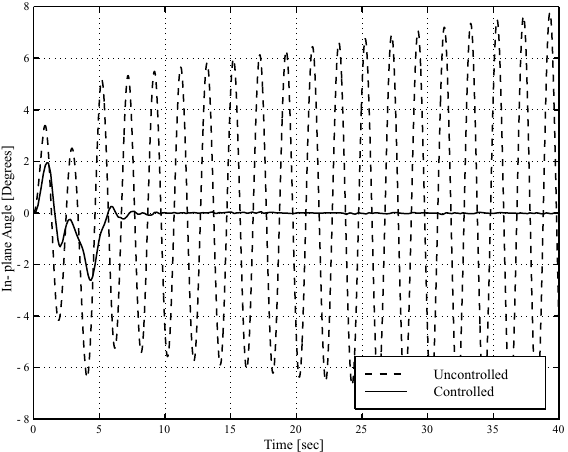
Fig. 21. Uncontrolled vs controlled in-plane oscillation angle φ ( t ) for the compound case using the fuzzy controller.